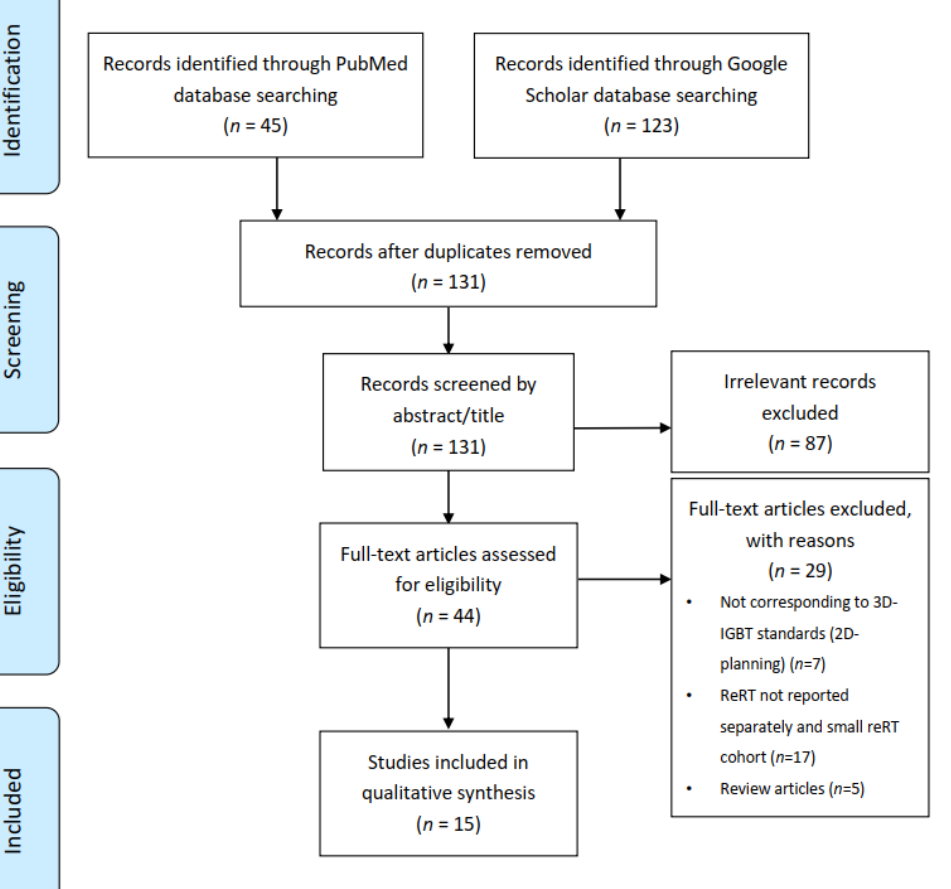
Figure 1. Data selection process: Preferred Reporting Items for Systematic Review and Meta-Analyses (PRISMA) flow diagram.